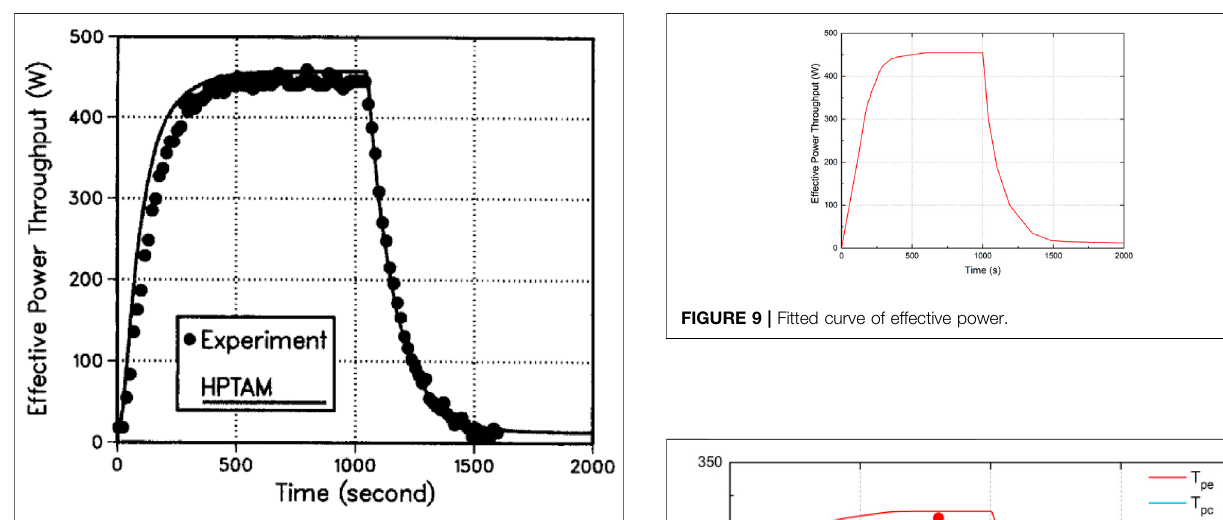
FIGURE 8 | Original data of effective power (Tournier and El-Genk, 1994).